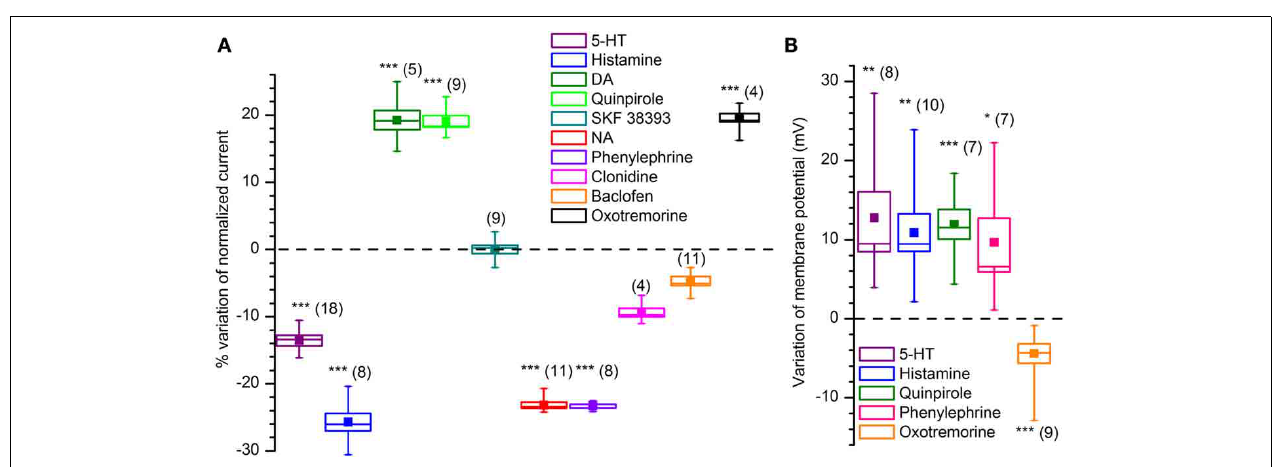
8Br-cAMP. Current tracings in control (D) and in the presence of 10 μ M 8Br-cAMP (E) ; (F) Comparison of the I/V curves recorded in control (blue dots) and 8Br-cAMP (green dots); n = 6; the difference, tested with Two-Way ANOVA and post-hoc Bonferroni test, is significant for the potentials more negative than − 80mV. All recordings were realized in EC2 with the addition of BL1 and BL2, at 34 ◦ C.